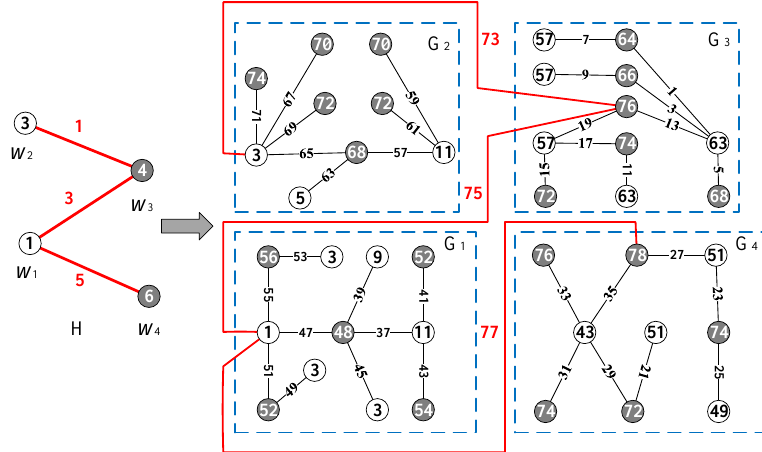
Figure 2. An example for illustrating the proof of Theorem